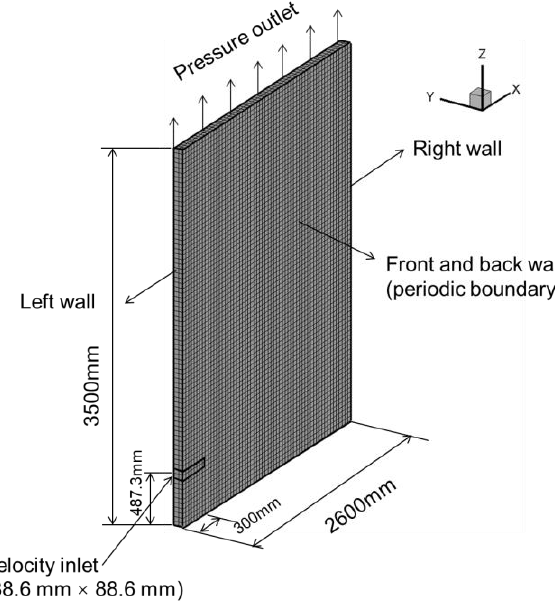
Figure 1. Two-dimensional slot model.